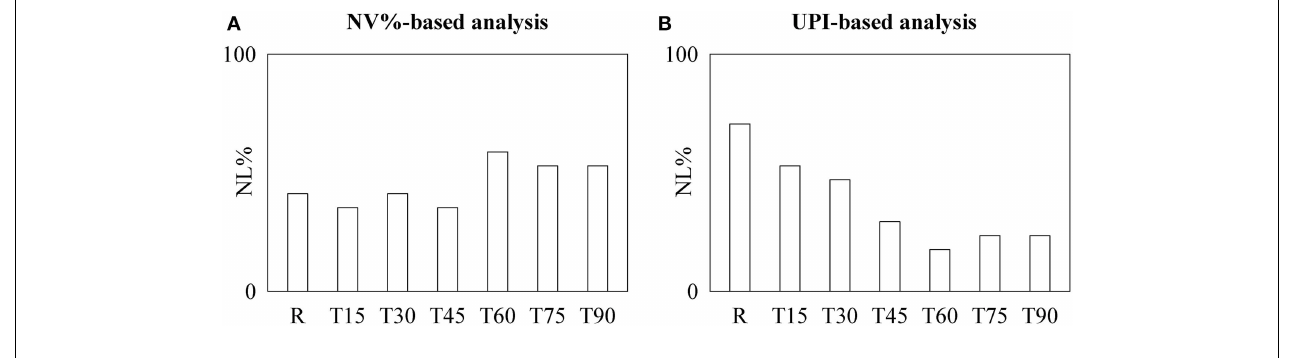
FIGURE 2 | The bargraphs show the percentage of healthy humans exhibiting nonlinear dynamics, NL%, as detected by the NV%-based time irreversibility (A) and UPI-based local